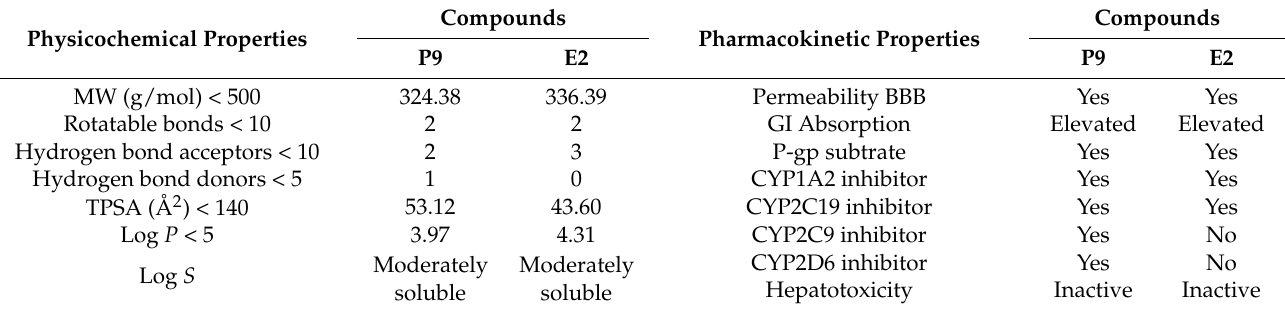
Table 5. Calculated physicochemical and pharmacokinetic parameters of benzimidazole derivatives by